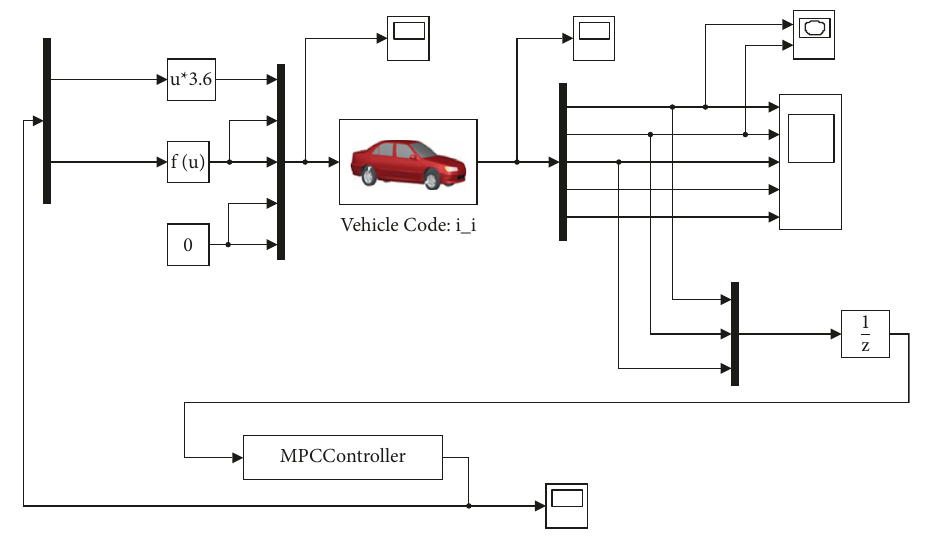
Figure 9: CarSim/Simulink joint simulation platform.